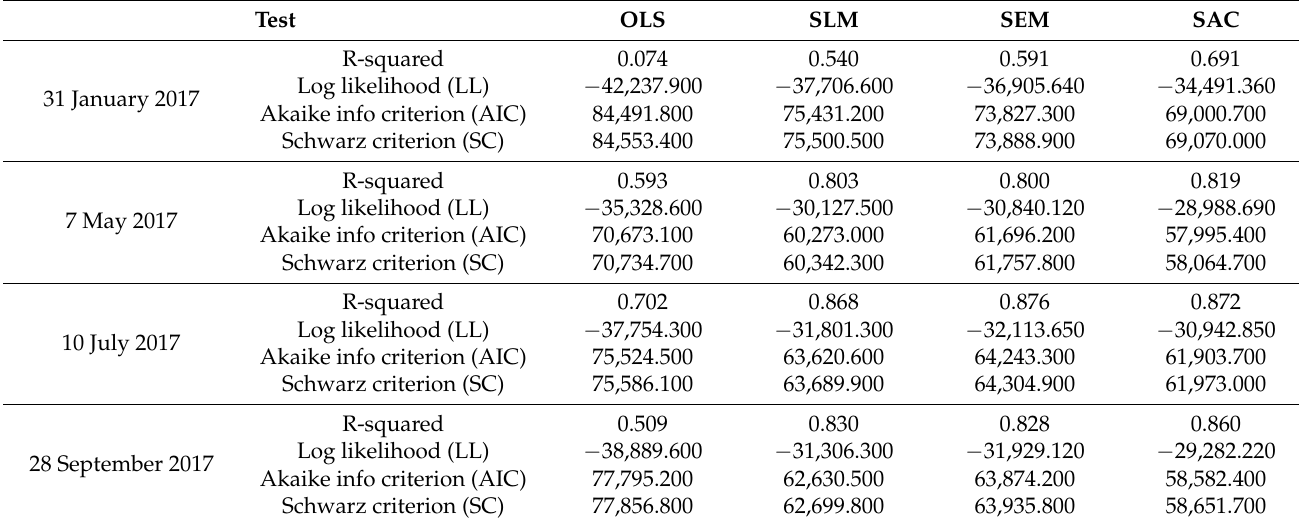
Table 3. OLS, SLM, SEM, and SAC: 31 January 2017, 7 May 2017, 10 July 2017, and 28 September